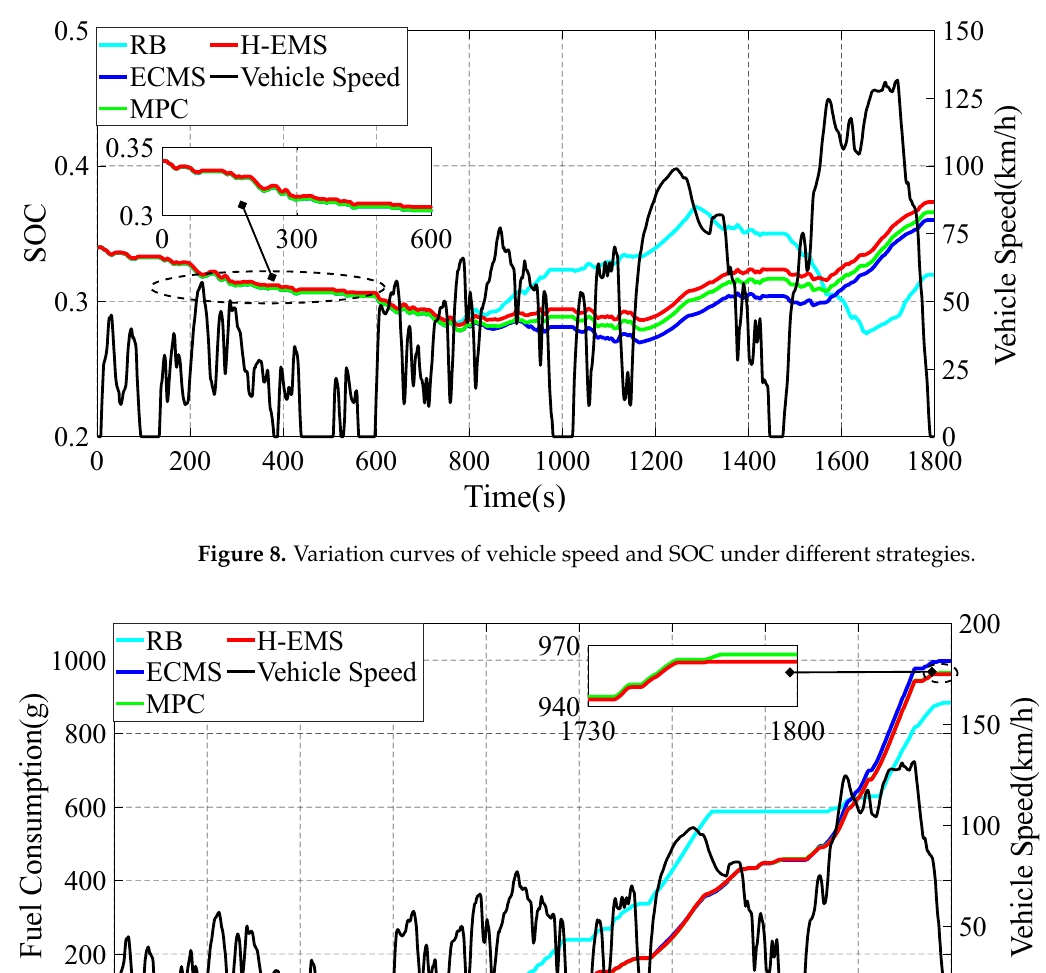
Figure 10. Variation curves of vehicle speed and equivalent fuel consumption under different strat- egies. Aiming to evaluate the comprehensive energy-saving potential, Figure 10 shows the comparison of the equivalent fuel consumption among control methods, and the detailed statistics are shown in Table 5. Compared with others, the value of the equivalent fuel consumption of the H-EMS is the lowest, indicating the best energy-saving potential. Alt- hough the fuel consumption of the RB strategy is the smallest, the value of the equivalent fuel consumption is the highest, reaching 972.7 g. As for the value of the ECMS, the equiv- alent fuel consumption of the vehicle is 897.6 g, which is 7.72% lower than that of the RB